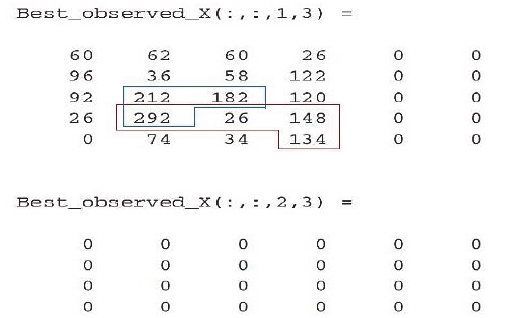
Fig. 15. Emerging complex dummy sub-cells after scheduling in a